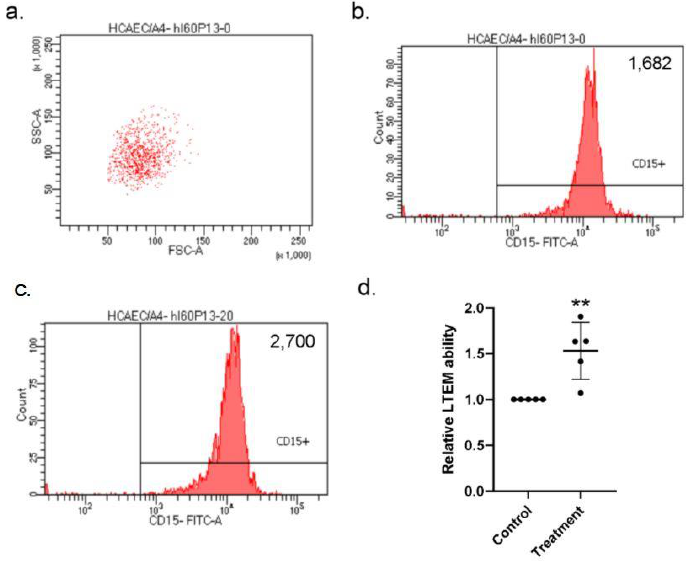
Figure 6. LTEM assay showed that the endothelial layer was more susceptible to in vitro neutrophil infiltration with S100A4 treatment. ( a ) To examine whether the weakened endothelial layer was more susceptible to neutrophil infiltration, we conducted the LTEM assay. ( b , c ) S100A4 treatment on the endothelial layer allowed more HL-60 cells to penetrate (2700 vs. 1682). ( d ) By three inde- pendent assays (three rounds * replications, one replication failed), more HL-60 cells penetrated the endothelial layer and a 1.5-fold higher LTEM ability was observed with S100A4 treatment. Each dot denoted the relative LTEM ability of one assay. Data were presented as mean ± SD. **with a denoted